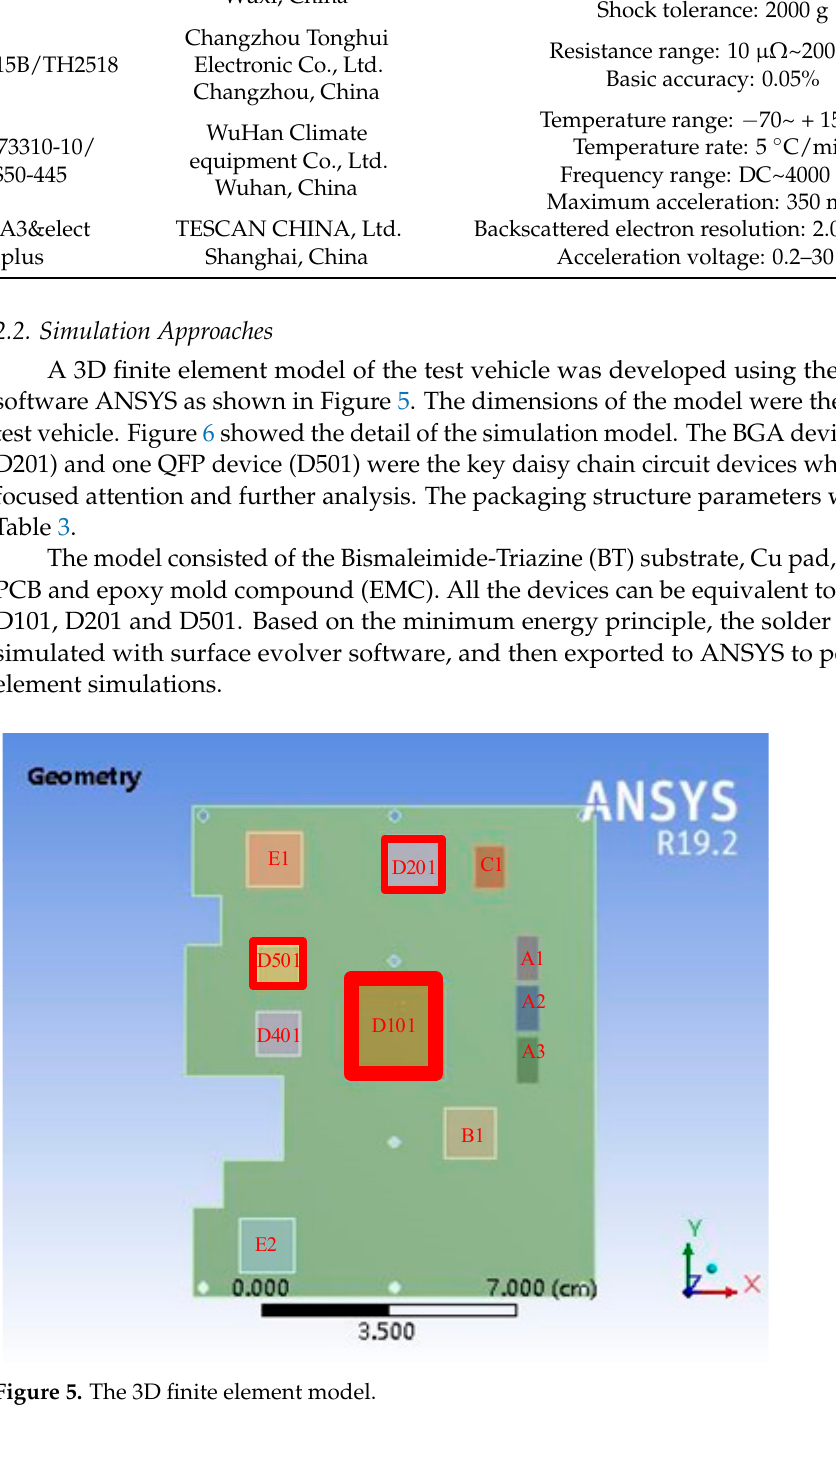
Figure 6. The finite element model of the key device: ( a ) D201, ( b ) D501. Table 3. Packaging structure parameters in FEA. Component